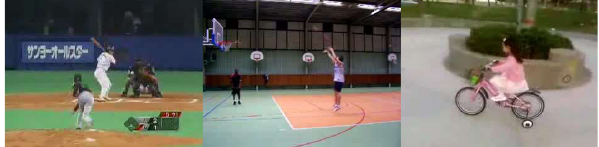
Figure 22. Samples from UCF50 dataset [217].